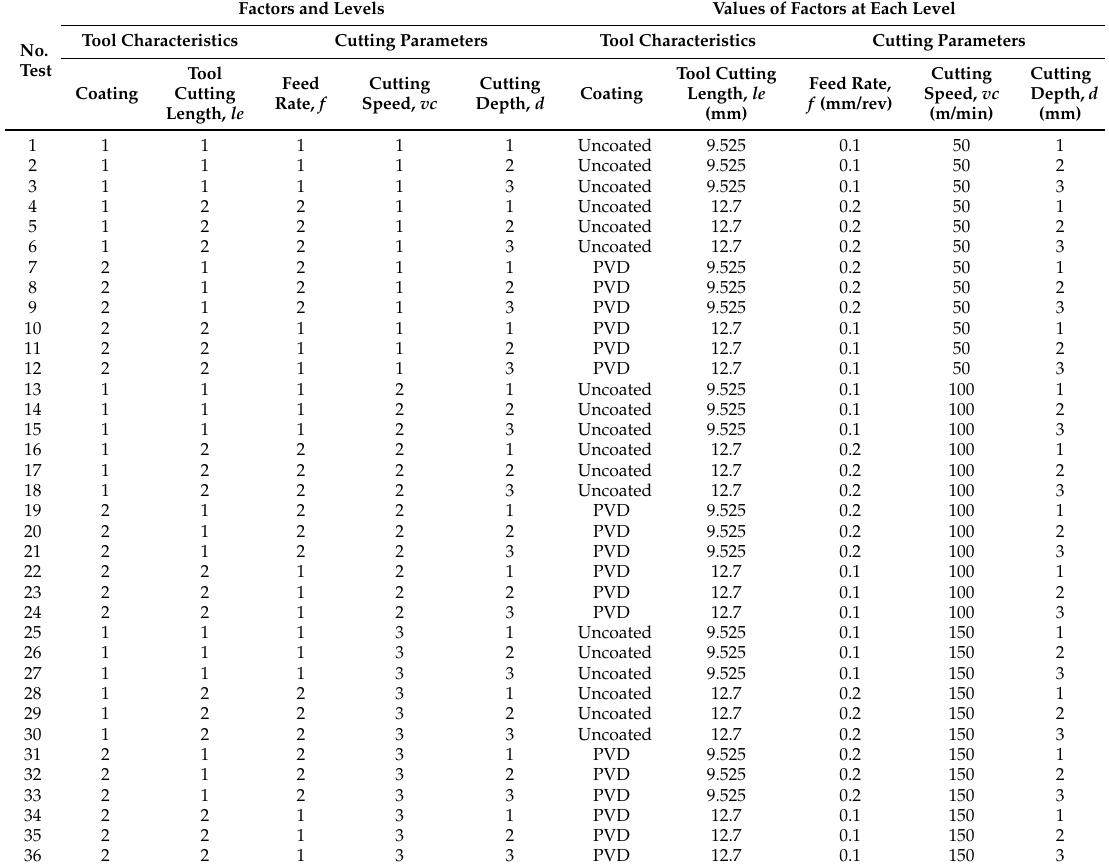
Table 5. Values of the factors at each level.